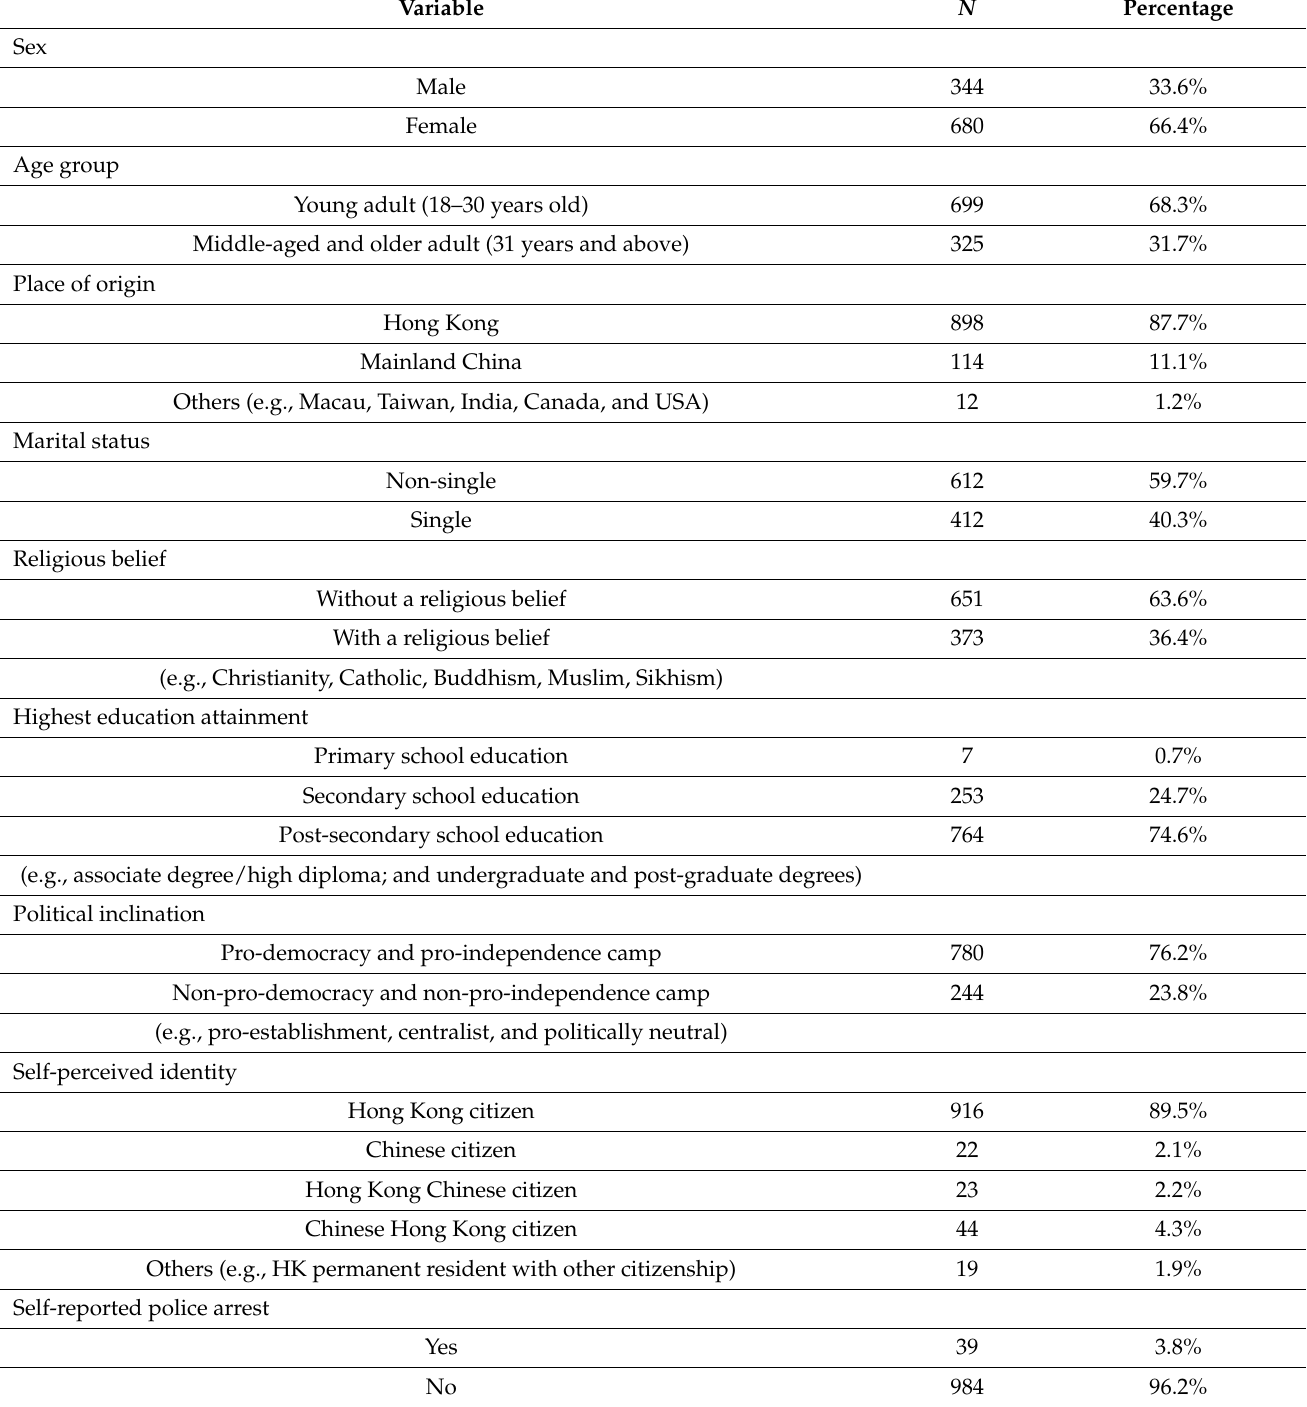
Table 1. Sample demographic characteristics ( N =